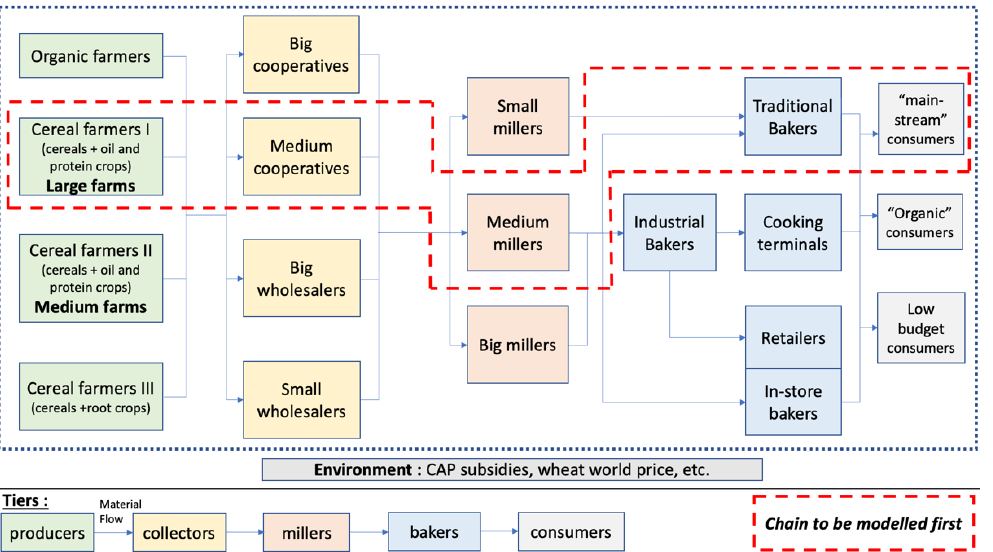
Figure 5. French wheat to bread FVC agents to be modelled as part of the ABM simulation modelling conceptualisation, with the highest priority agents indicated by a red dashed line.